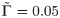
SP phase in the phase diagram, for Γ˜=0.05 and L = 1.The colour map represents the value of xw for the position of the domain wall between LD and HD zones, as determined numerically. Where no data is shown xw was negative or larger than L, indicating respectively a LD or a HD state point. The represented points thus identify the zone corresponding to a SP, which is to be confronted to the analytical estimation of its phase boundaries (black lines).